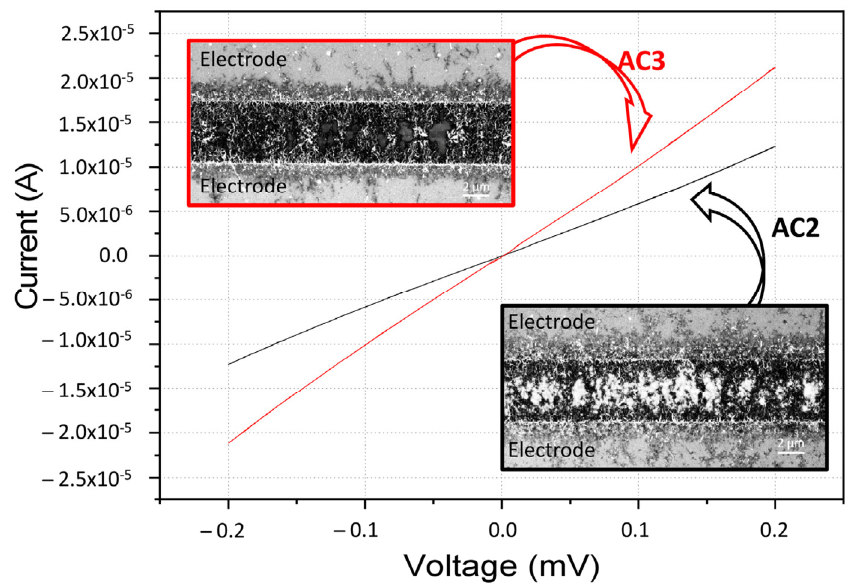
Figure 5. IV measurements performed on two samples with the same AZO:CNT weight ratio (4.2) and two different density layers, lower for AC2 and higher for AC3. SEM images of the active region for the two samples are reported in the insets.